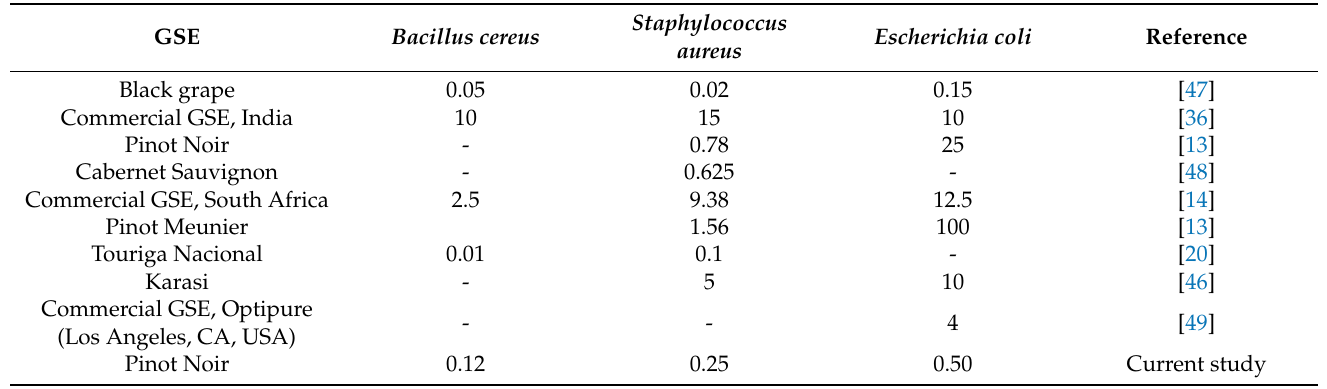
Table 7. Comparison of the MICs (mg/mL) of tested GSEs with results from other